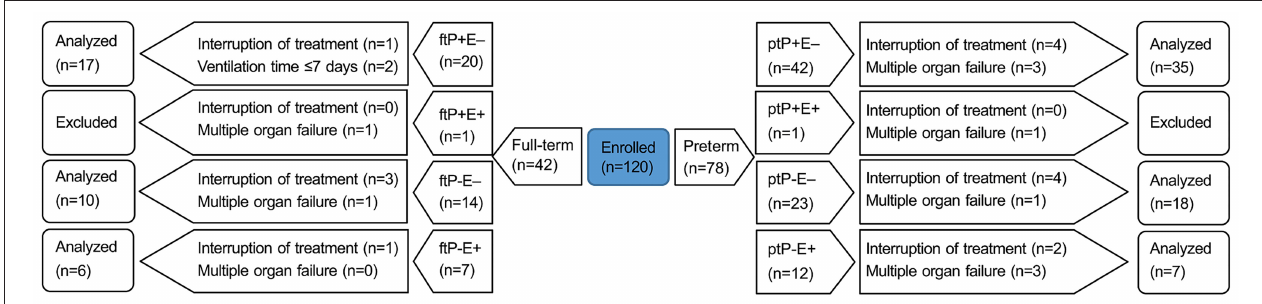
FIGURE 1 | A flow diagram of the trial. Neonates were divided into eight groups based on three categories: preterm (pt) or full-term (ft); NVAP (P + ) or non-NVAP (P–); and extrapulmonary infection present (E + ) or absent (E–). NVAP, neonatal ventilator-associated